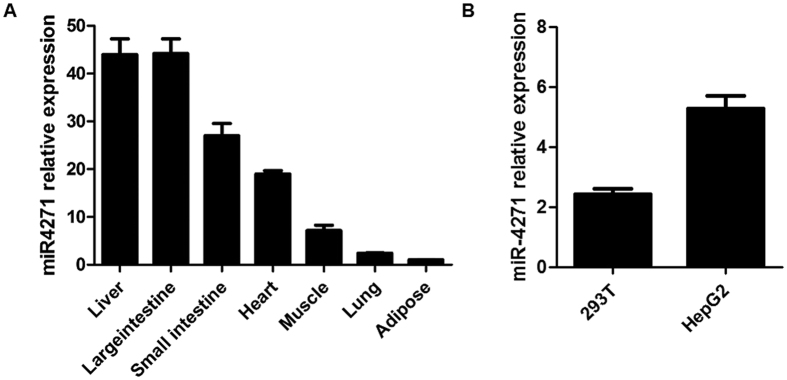
Comparision of real-time quantitative PCR for miR-4271 expression in different human tissues (A) or human cell lines including HepG2 and 293T (B). Data are means ± (SE) from three independent experiments analyzed in six replicates. Data are normalized with reference microRNAs, as mentioned in the text.